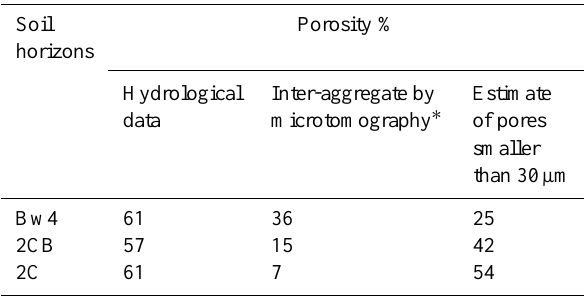
Table 5. Comparison between the porosity data obtained by hydro- logical and microtomographic